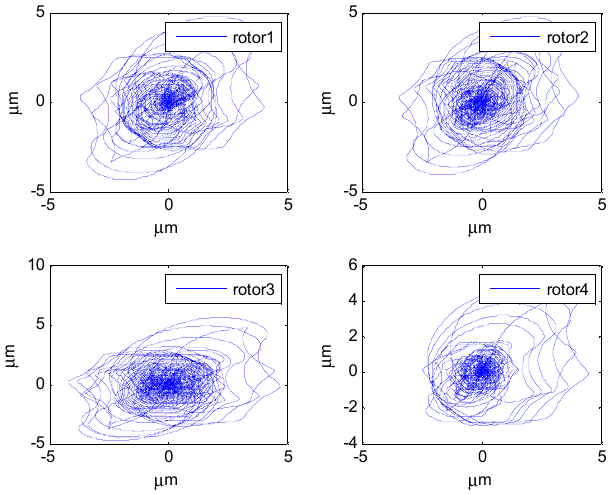
Figure 27. The rotor displacement with feedforward